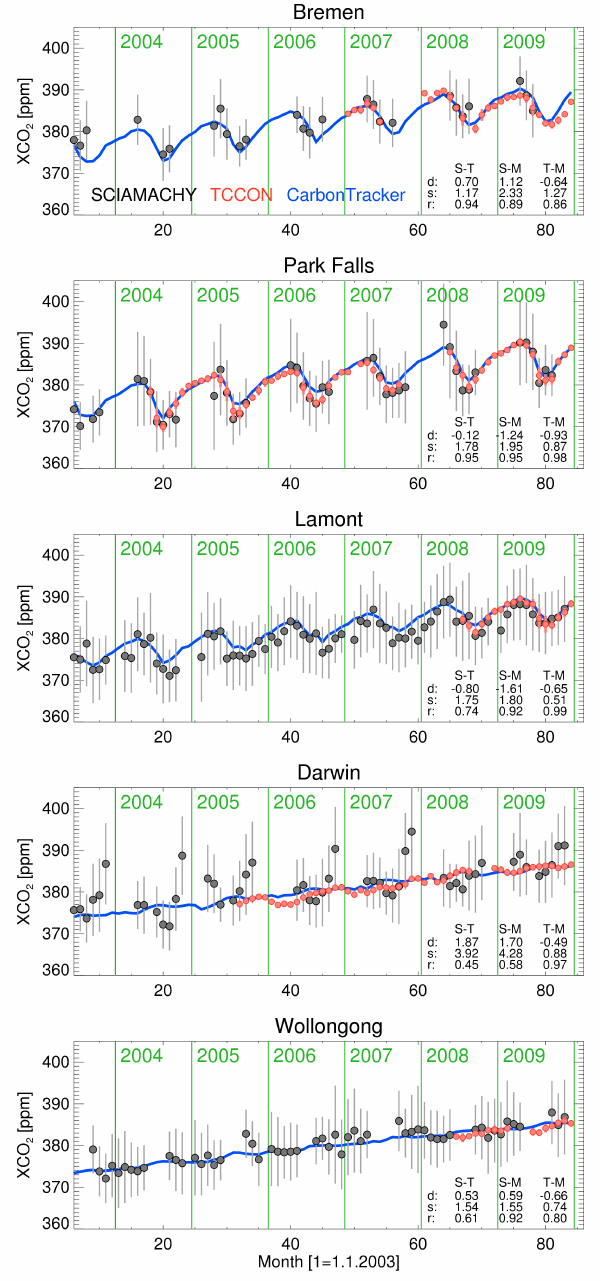
Fig. 1. Intercomparison of the SCIAMACHY WFMDv2.1 XCO 2 time series of monthly means (black) with ground based Fourier Transform Spectroscopy (FTS) measurements (red) and Carbon- Tracker (blue) at selected TCCON sites for the years 2003–2009. The vertical bars correspond to the standard deviations of the data within a given month. The following numbers have been computed based on the monthly averages (S = SCIAMACHY, T = TCCON, M = Model): d is the absolute mean difference (in ppm), s denotes the standard deviation of the difference (in ppm), and r is the corre- lation coefficient. The complete results are summarised in Table 1.